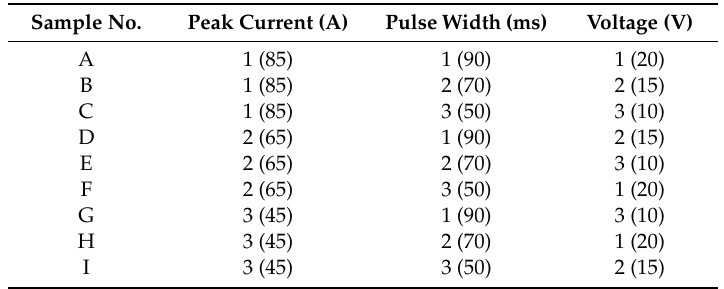
Table 8. Orthogonal test scheme arrangement of the HESD repair welding. Sample